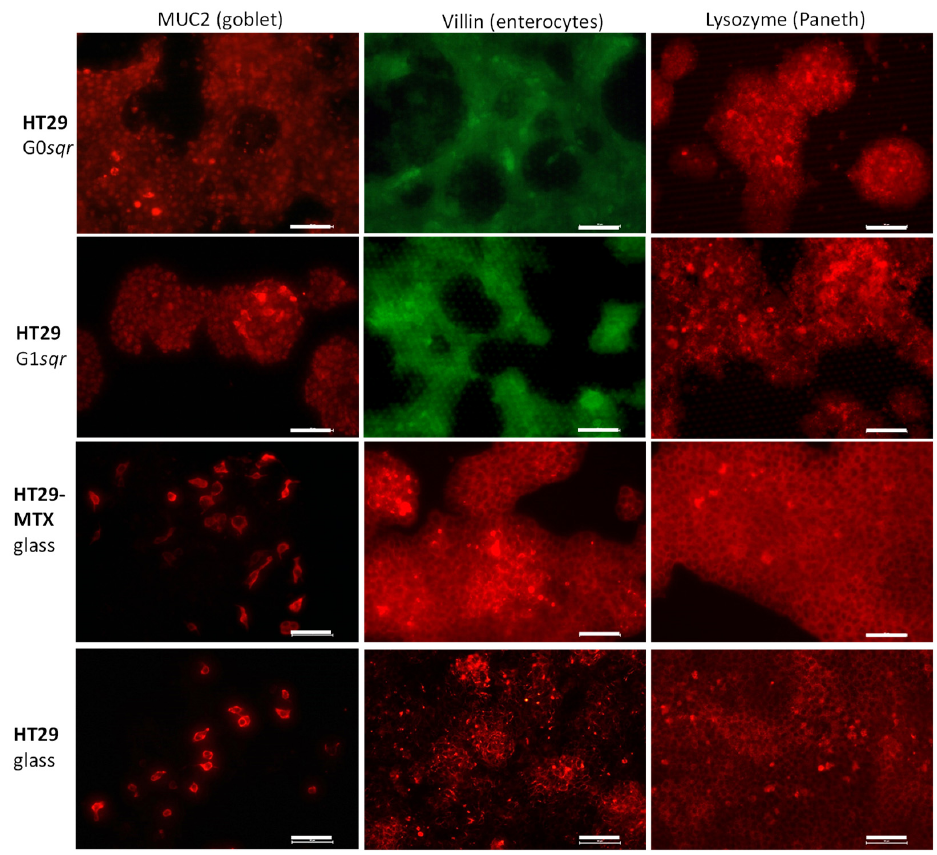
Figure 4. Epifluorescence of HT29, as well as HT29-MTX cells grown on different substrates for 8 days, immunolabelled by antibodies for MUC2, villin, lysozyme and then stained TRITC-(red) or FITC-(green) labeled secondary antibodies. Number of independent experiments: n = 2. Scale bar: 50 μ m.